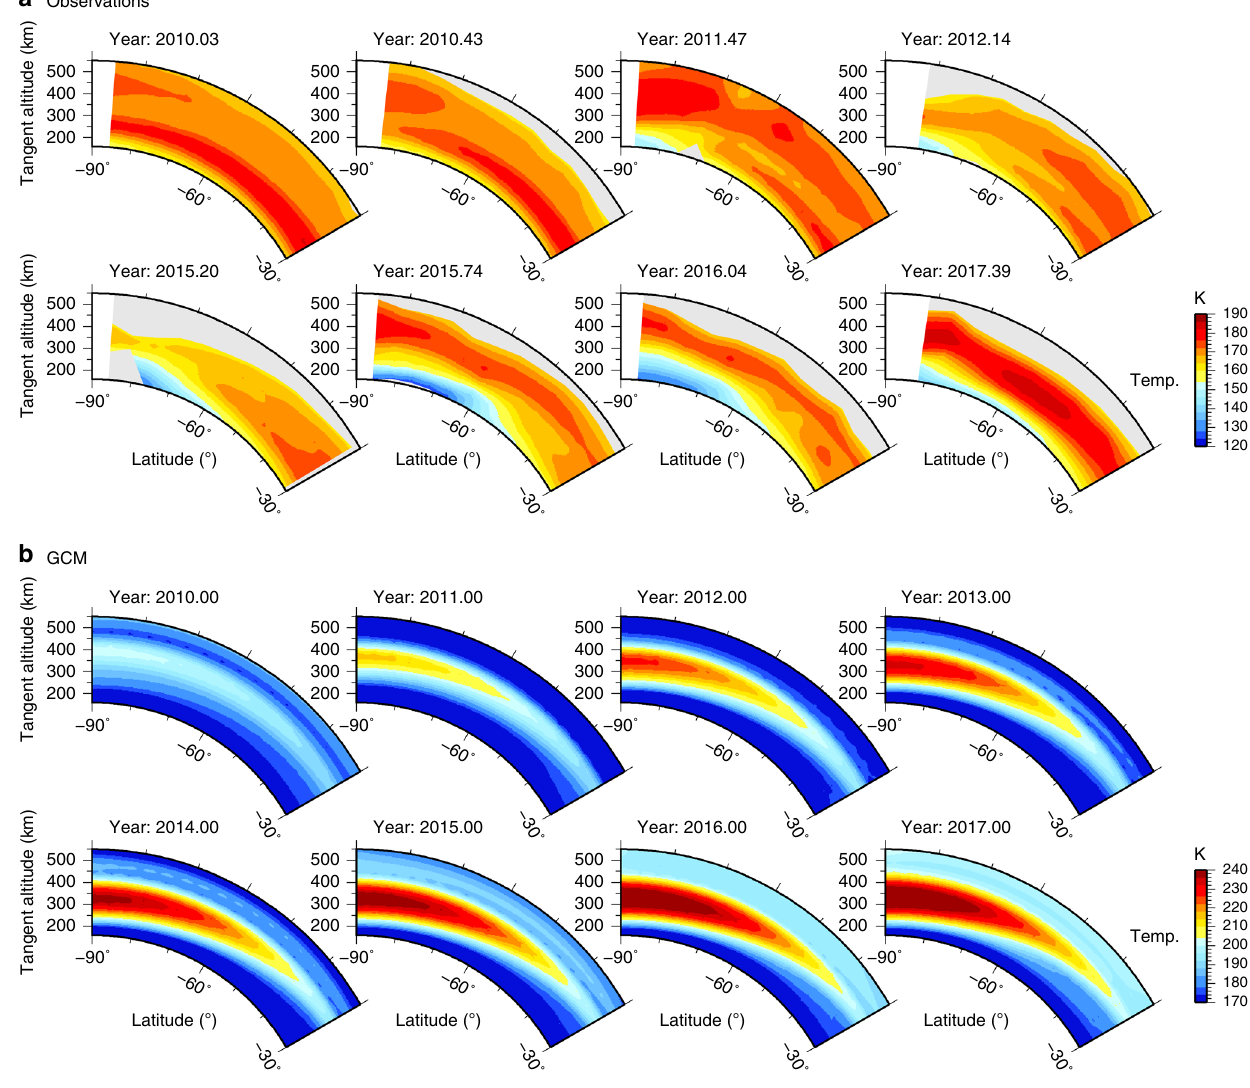
Fig. 3 South-polar vortex temperature evolution. a Temperature cross-sections derived from Cassini CIRS 14 cm − 1 limb mapping observations. Grey areas indicate where signal-to-noise is too low to allow a reliable temperature determination. Observations clearly show development of an initial mesospheric hot-spot over the south pole at 400 km due to adiabatic heating, followed by a rapid cooling in 2012 which lasts for 4 years, and fi nally a returning hot-spot in late-2015. b Predictions from a general circulation model (GCM) 17 during the same period do not show the disappearance of the polar hot-spot.